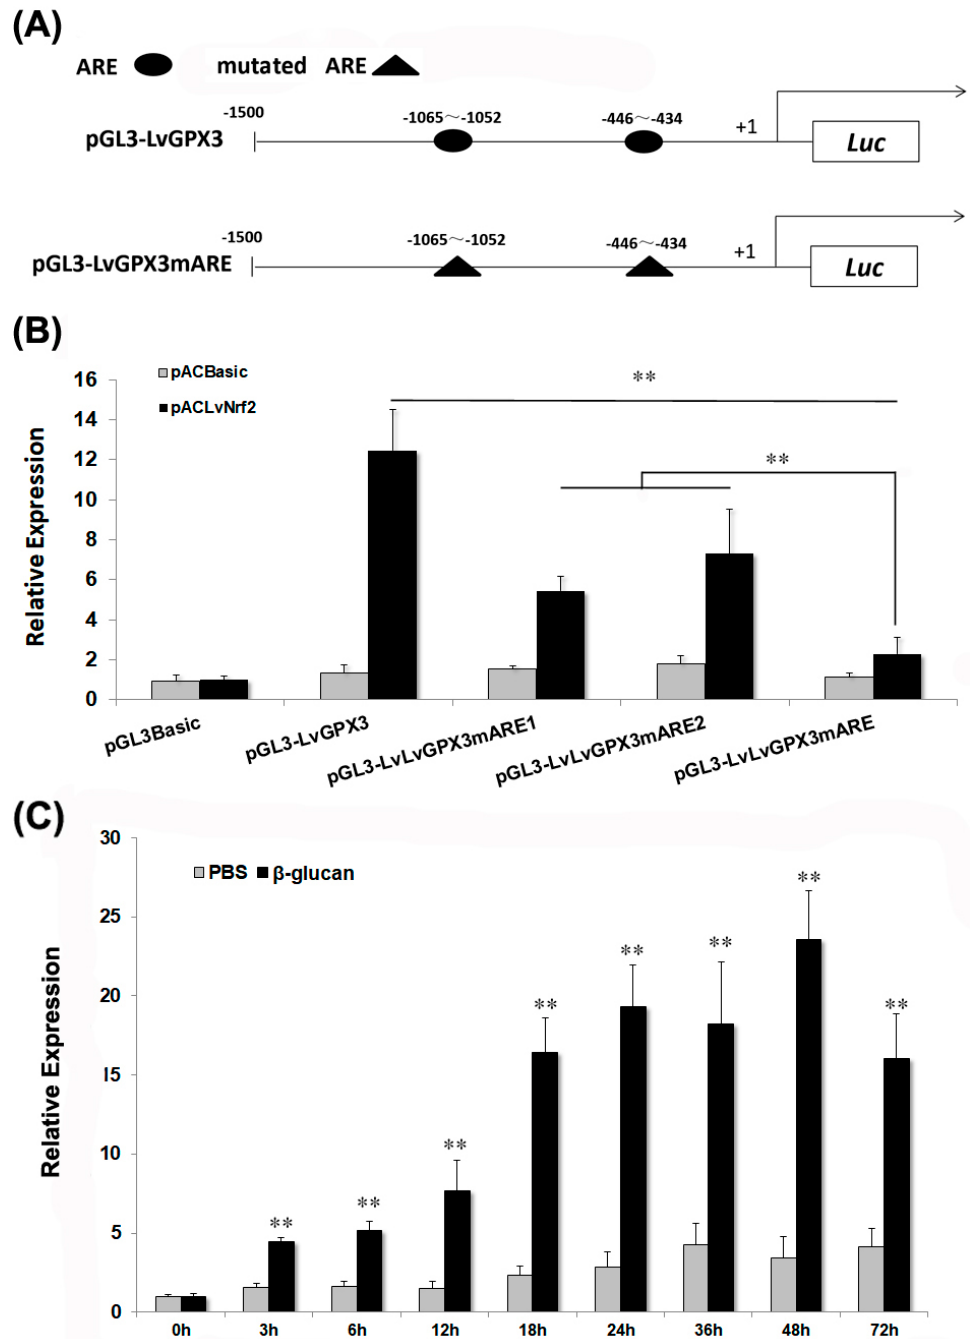
Figure 3. LvGPX3 is regulated by oxidative stress response pathway. ( A ) Schematic diagram of LvGPX3 promoter regions in the luciferase reporter gene assay is constructed. +1 denotes the transcription initiation site for LvGPX3 gene. Luc denotes the firefly luciferase reporter gene. The putative AREs are indicated by oval boxes. The mutated AREs are indicated with triangle boxes. ( B ) Activation of the LvGPX3 promoter by LvNrf2. The relative luciferase activity of pGL3B-LvGPX3, pGL3B-LvGPX3mARE1, pGL3B-LvGPX3mARE2 and pGL3B-LvGPX3mARE were detected. The bars indicate mean values ±S.D. of luciferase activity ( n = 3). ( C ) The mRNAs were collected at 0, 3, 6, 12, 18, 24, 36, 48 and 72 h after β -glucan injection. The relative expression of LvGPX3 upon β -glucan injection was normalized with LvEF1 α and compared to time zero. The bars represent the mean values ±S.D. of three replicates. The statistical significance was calculated using Student’s t - test (** indicates p < 0.01).